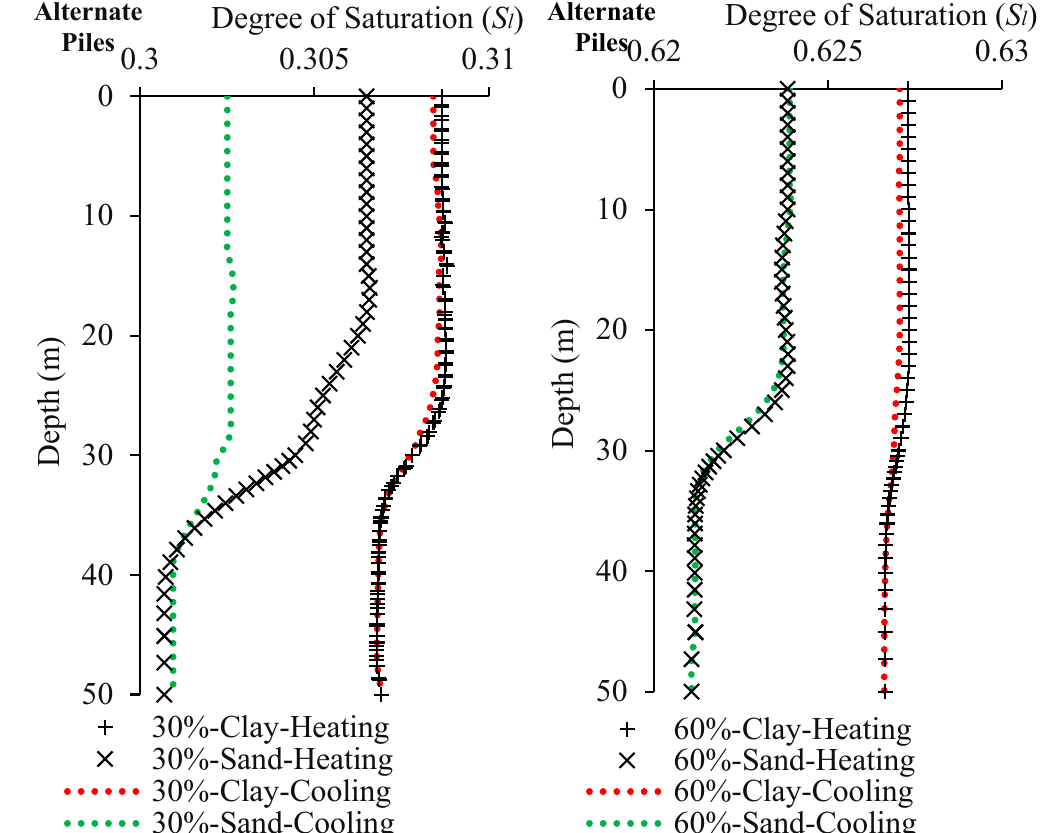
Figure 17. The results of the degree of saturation with depth for the cyclic heating and cooling of alternate GEPs in the group .